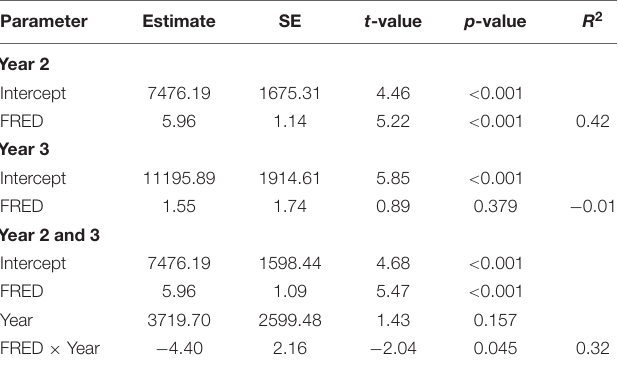
TABLE 3 | Results of linear regressions predicting total energy in fuels (KJ m − 2 ) as a function of FRED during prescribed fire in longleaf pine woodlands in southwest Georgia, United